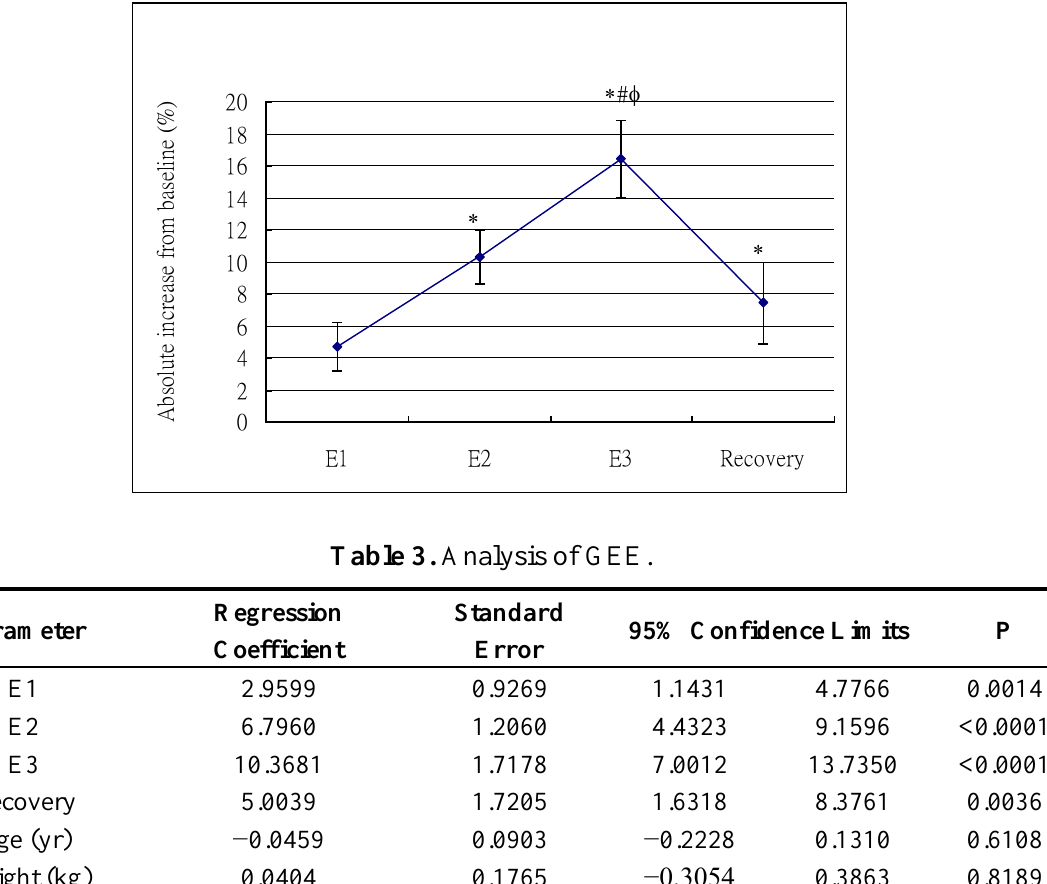
Figure 2. Percentage of absolute increase in caloric expenditure relative to baseline.